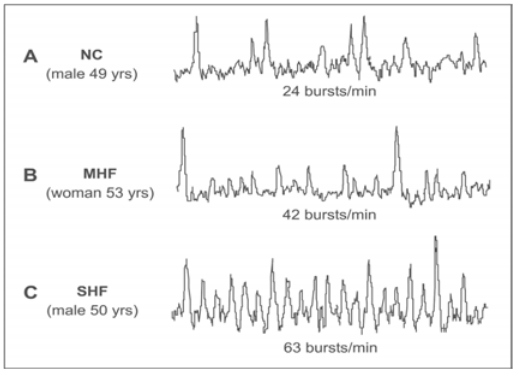
Fig. 1 – Muscle sympathetic nerve activity (MSNA) from con- trol (NC, A), mild (MHF, B) and severe (SHF, C) heart failure patients at rest. MSNA was directly measured from the peroneal nerve using the microneurography technique. Note that rest- ing MSNA was greatest in the patients with severe heart failure (Data from Cardiovascular Rehabilitation and Exercise